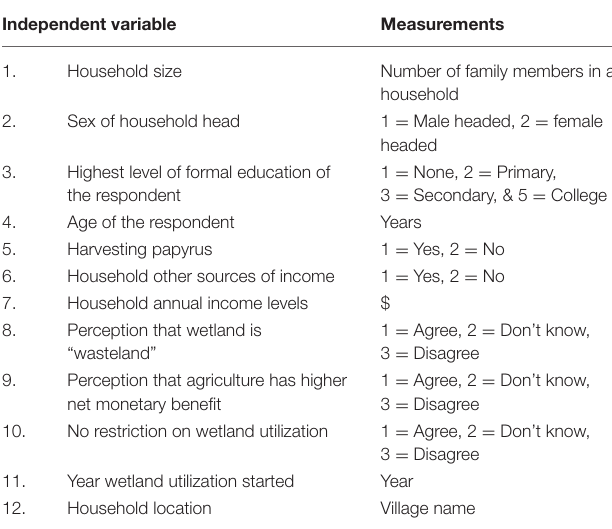
TABLE 1 | Description of variables fitted in the model. Dependent variable Whether a household uses the wetland for agriculture (1 if yes: 0 if